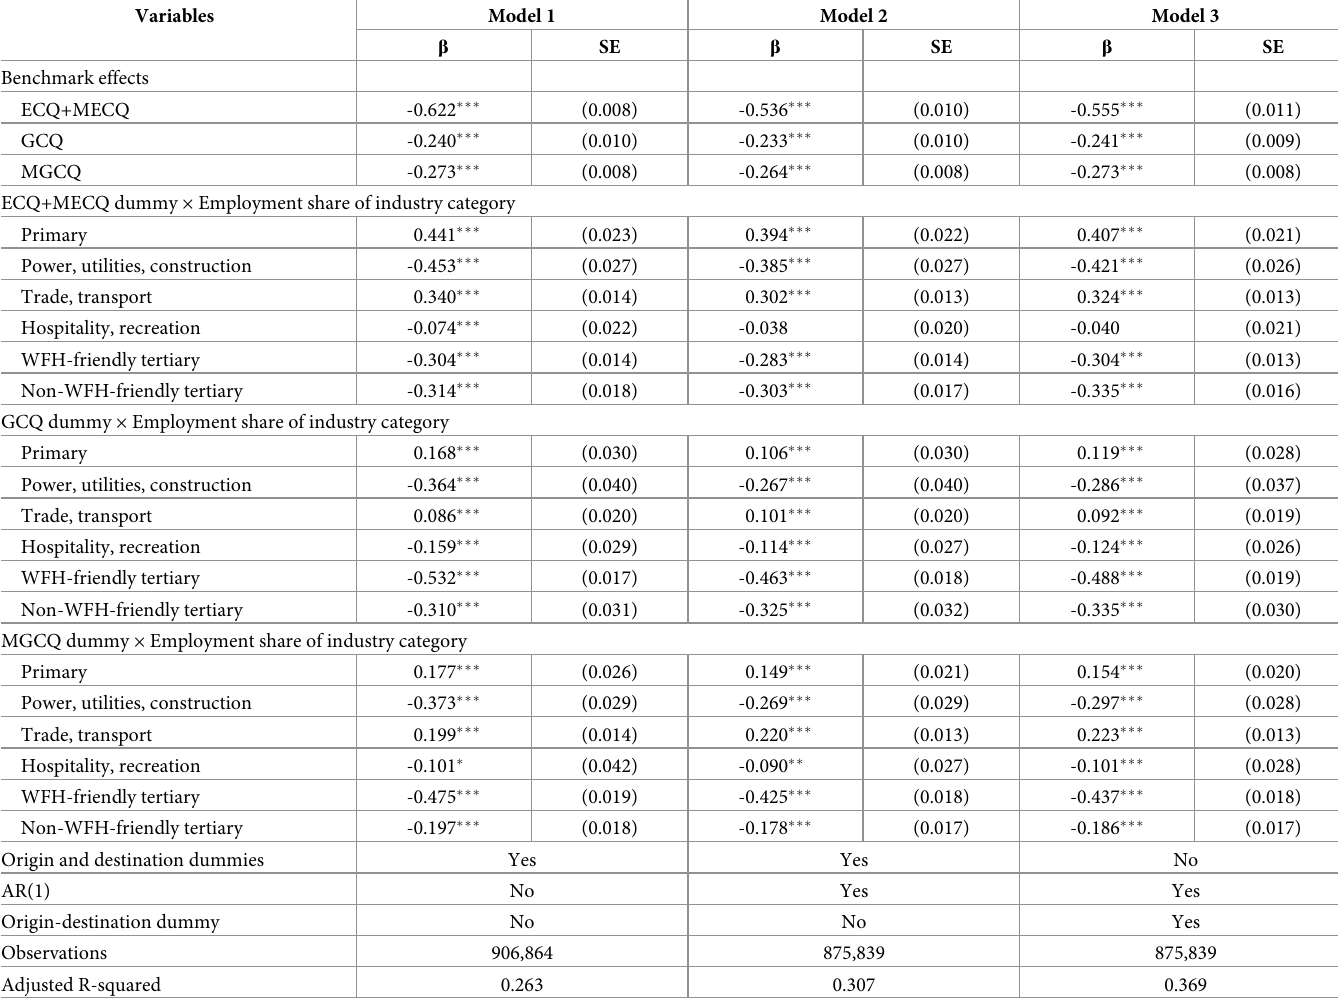
Table 5A. Effects of lockdown measures by destination city industrial composition (afternoon flows leaving the top 300